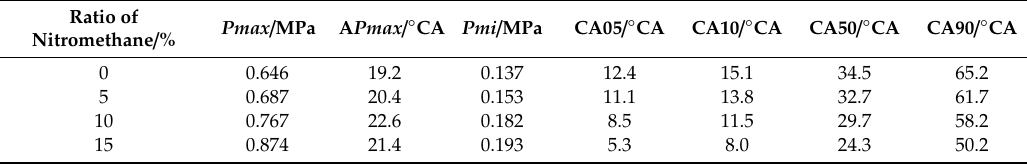
Table 5. Characteristic parameters with di ff erent proportion of nitromethane for methanol.